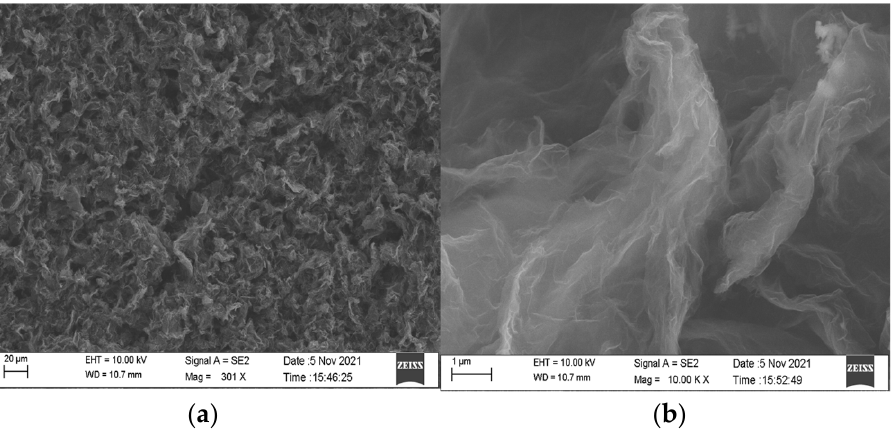
Figure 5. ( a ) SEM image of rGO-SDS composite film. ( b ) Partial enlargement of the majority .